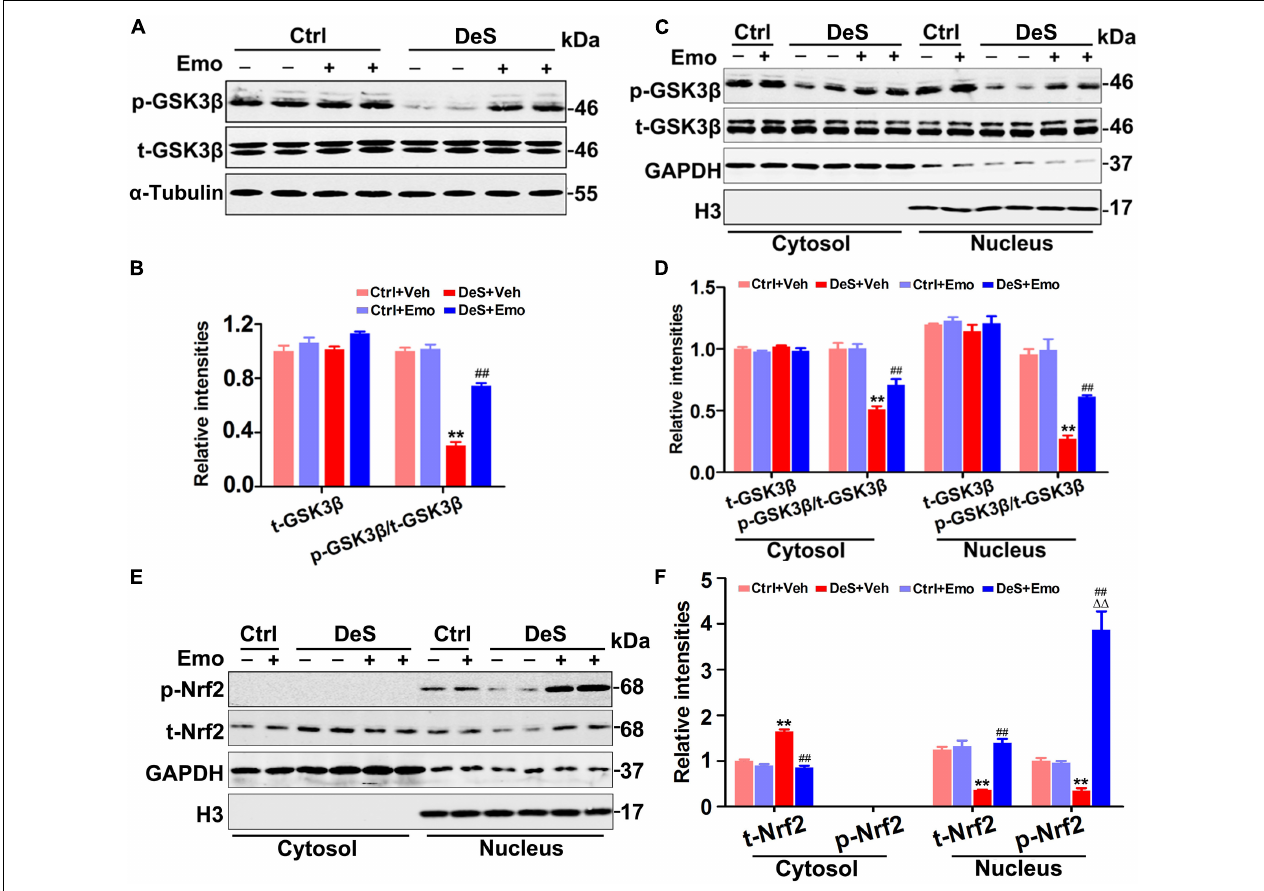
FIGURE 6 | Emodin inhibited hippocampal glycogen synthase kinase 3 β (GSK3 β ) activation. The levels of total GSK3 β (t-GSK3 β ) and phosphorylated GSK3 β (p-GSK3 β , Ser9) were shown by Western blotting (A) and quantitatively analyzed (B) [ F ( 3 , 20 ) = 90.46 for p-GSK3 β /t-GSK3 β , p = 0.000] ( n = 6 brains/group). Meanwhile, the levels of t-GSK3 β , p-GSK3 β and total nuclear factor erythroid 2-related factor 2 (t-Nrf2) in the nuclear and cytoplasmic fractions were also tested by Western blotting (C,E) and quantitatively analyzed ( D,F , n = 6 brains/group). The loading amount of cytosolic samples was 10 µ g and the loading amount of nuclear samples was 20 µ g. Data were analyzed by one-way ANOVA with LSD post hoc test and presented as means ± S.E.M. ** p < 0.01 DeS + Veh versus Ctrl + Veh, (cid:49)(cid:49) p < 0.01 DeS + Emo versus Ctrl + Emo, ## p < 0.01 DeS + Emo versus DeS +